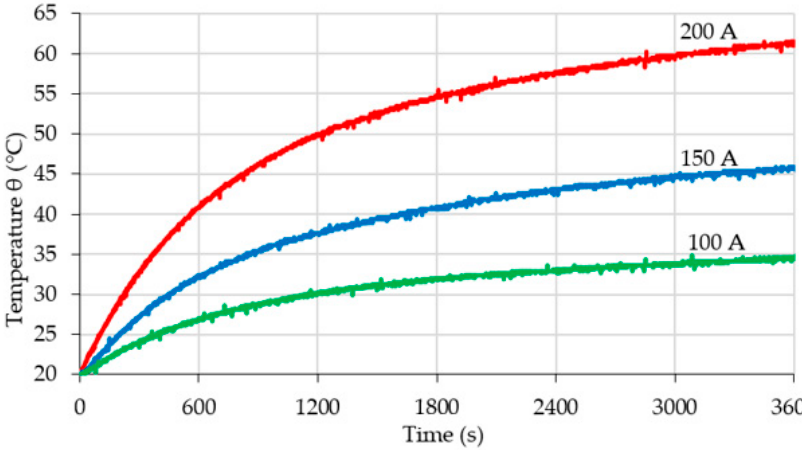
Figure 8. Temperature variation from the contact area by impedance bond and two steel conductors at different currents (100 A, 150 A, 200 A).